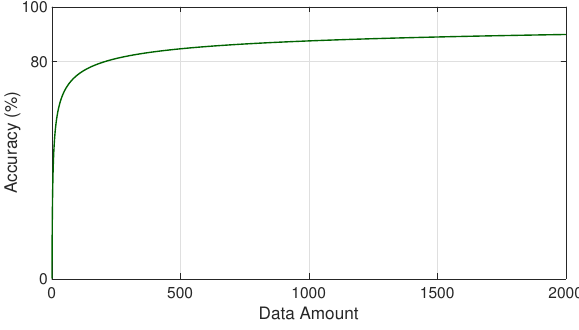
Figure 8. Expected accuracy under increasing amount of